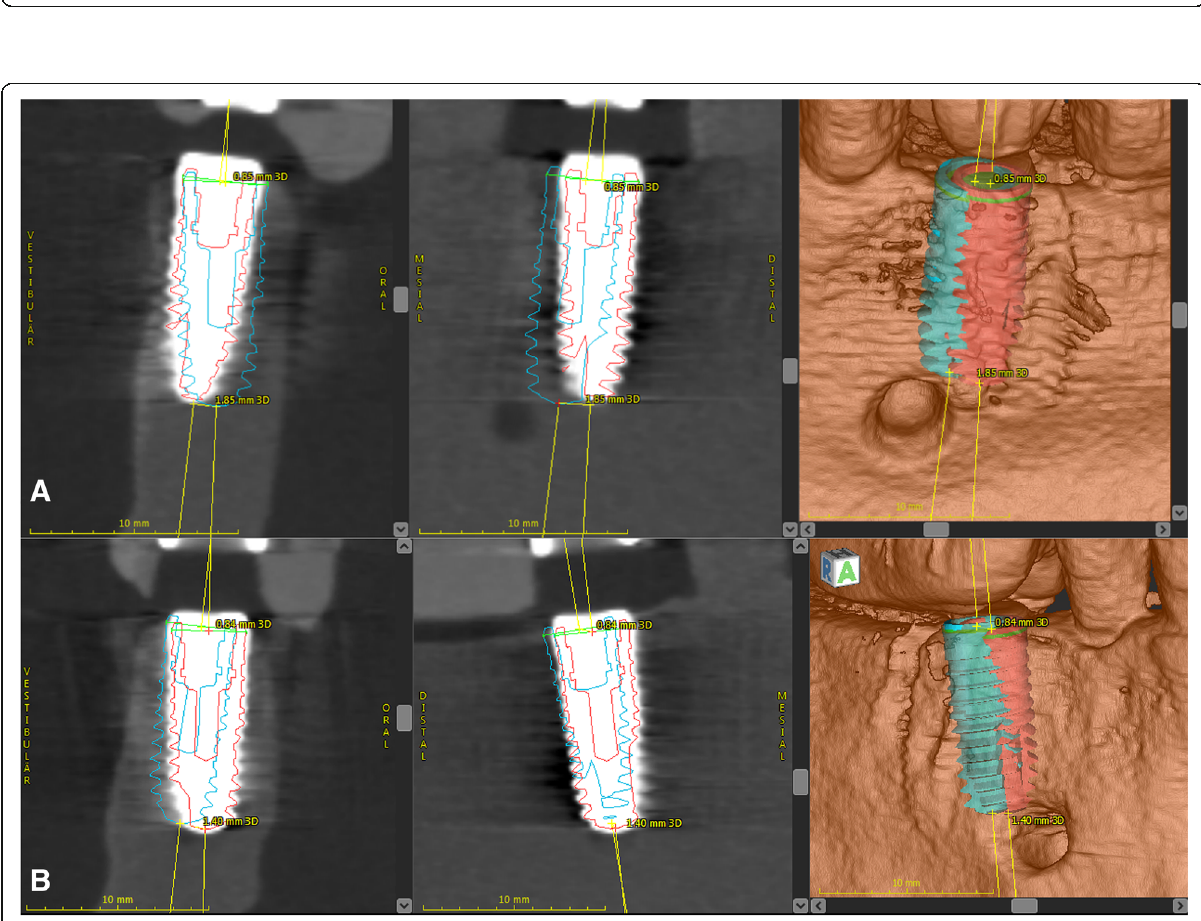
Fig. 3 Three-dimensional superimposition of the pre-operatively planned position (blue) and the actual position (red) of the implant. a In this case, a mesio-lingual mismatch of the implant in region 35 is detectable. b In region 45, there is a slight mismatch to the distal and vestibular direction. In both images, the implant tip shows a higher deviation than the implant